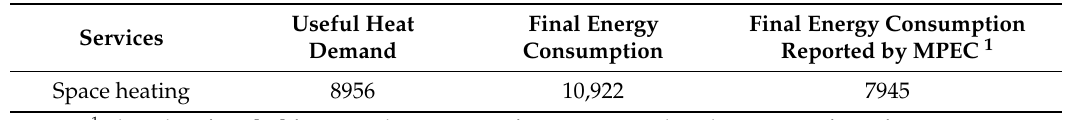
Table 4. District heat consumption in TJ per year.